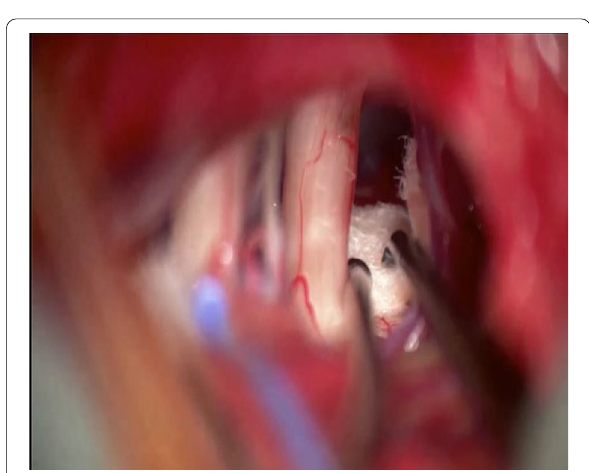
Fig. 2 Intraoperative view of the same patient showing adequate mobilization of the SCA away from TN and placing the Teflon implant